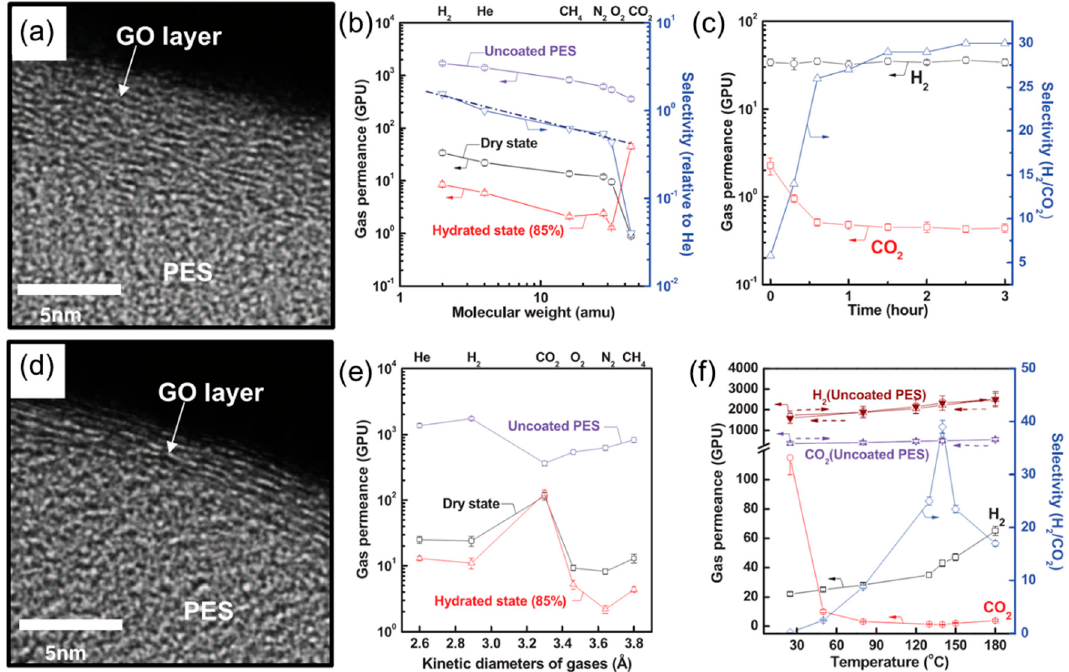
Figure 3. The structure and gas transport behavior of GO membranes prepared by dip and spin- coating ( a – c ). ( a ) Cross-sectional TEM image. ( b ) Gas permeance as a function of molecular weight under dry and humidified conditions. The dashed line represents the ideal Knudsen selectivity. ( c ) H 2 /CO 2 separation properties as a function of time. The structure and gas transport behavior of GO membranes prepared by drop and spin-coating ( d – f ). ( d ) Cross-sectional TEM image. ( e ) Gas permeances as a function of gas kinetic diameters under dry and humidified conditions. ( f ) H 2 /CO 2 separation properties as a function of temperature. 1 GPU = 10 − 6 cm 3 (STP)/cm 2 ·s·cmHg. The dashed arrows indicate the testing temperatures increasing from 25 to 180 ◦ C and then back to 25 ◦ C. Reprinted